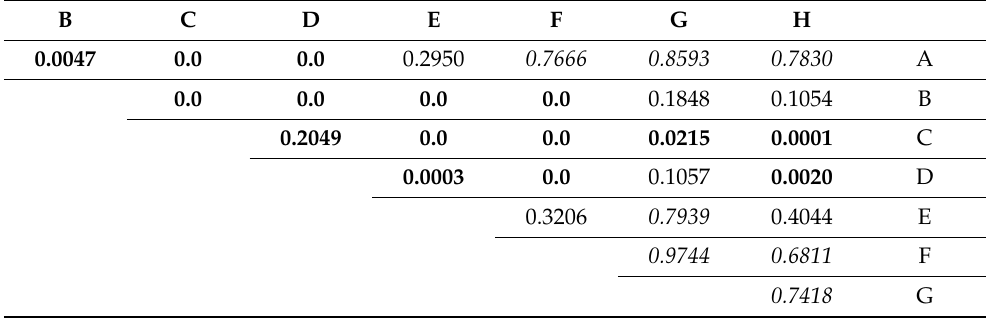
Table 5. Paired t -test, p -values and gross/red numbers showing a statistically significant difference.